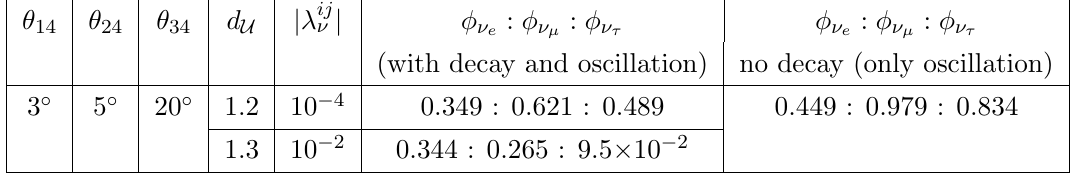
Table 2 . Same as table 1 but for the (cid:13)ux ratio for each (cid:13)avour of active neutrinos in 4-(cid:13)avour